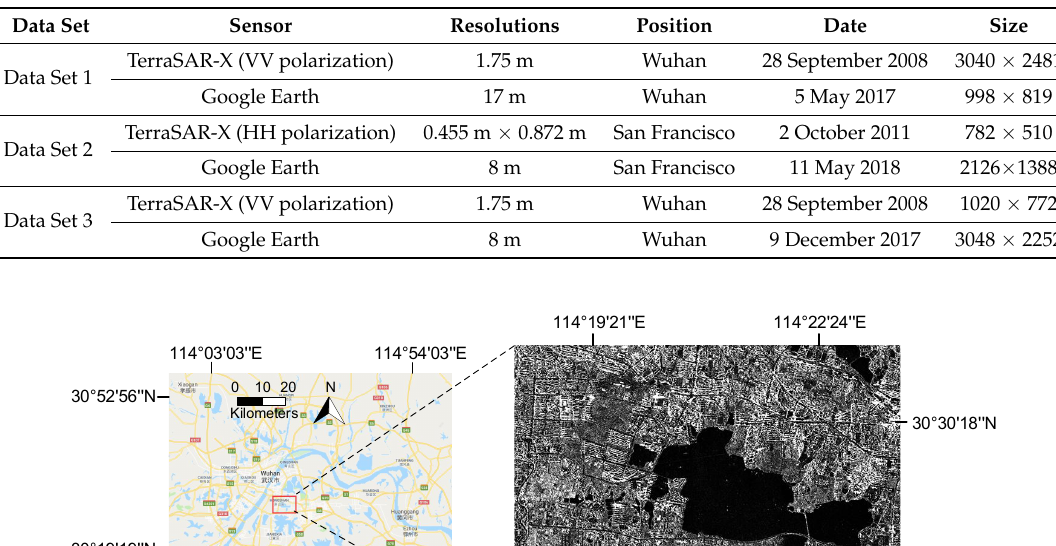
Table 1. Experimental images and their characteristics.